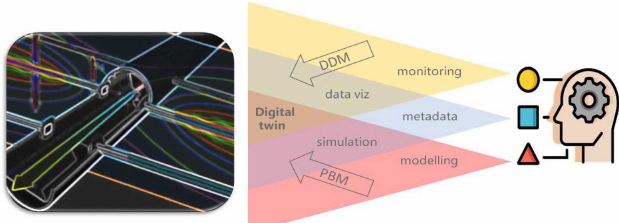
Fig. 14. Schematic visualisation of the repository monitoring strategy developed in MODATS with the data-driven model (DDM) and the physics-based model